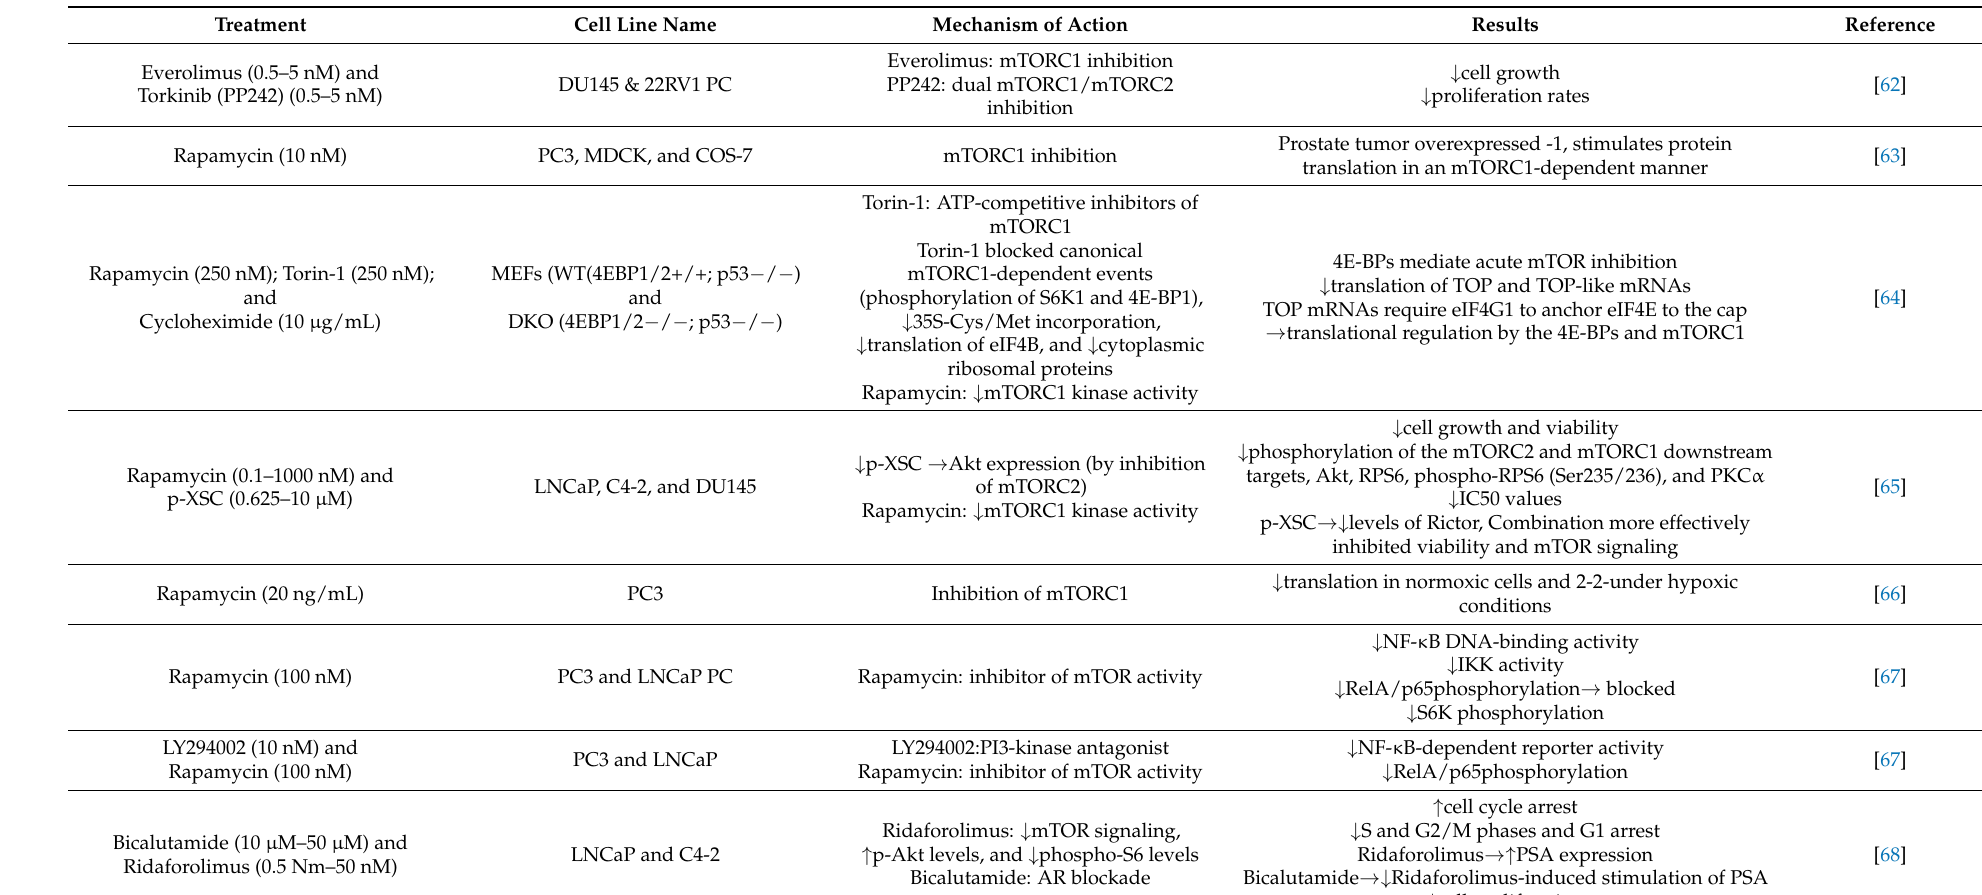
Table 1. In vitro studies on synthetic PI3K/Akt/mTOR inhibitors in